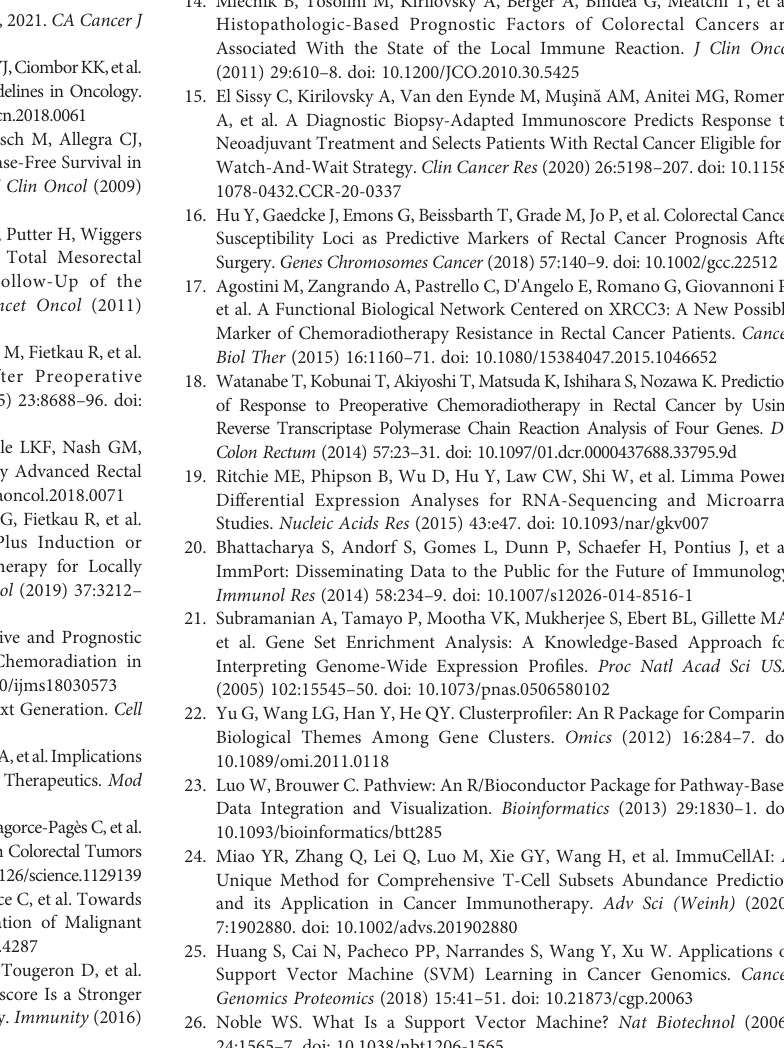
Supplementary Figure 2 | Comparison between the fractions of immune cells in the responder (R) and non-responder (NR) subgroup of the GSE35452 cohort via the ImmuCellAI